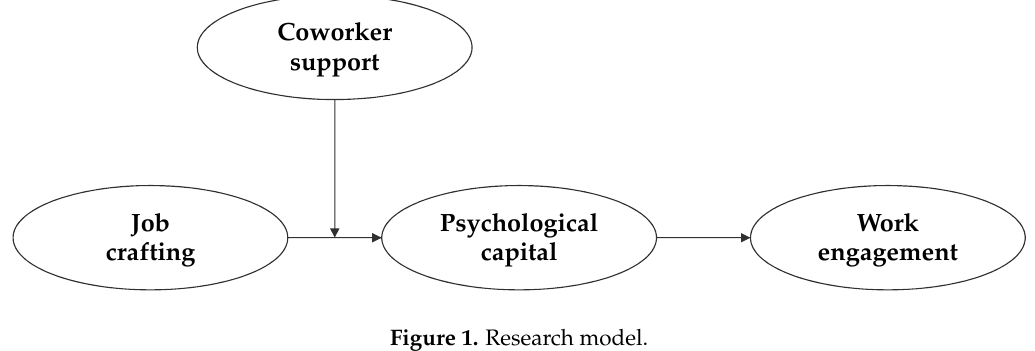
Figure 1. Research model.